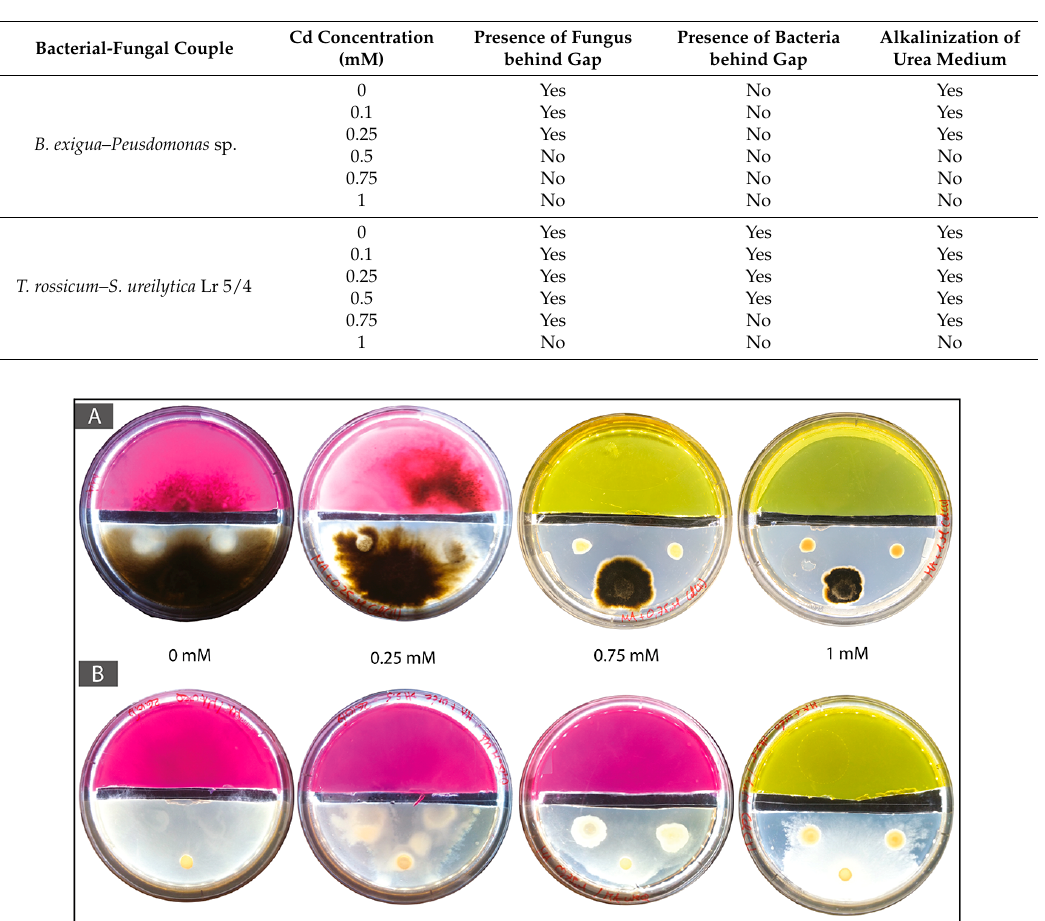
Table 3. Results of the Cd mobilization and immobilization experiment in two-compartments systems with the two synergistic couples ( B. exigua + Pseudomonas sp. and T. rossicum and S. ureilytica Lr 5/4) showing at each Cd concentration assessed whether (1) the fungus reached the immobilization area, (2) bacteria used fungal highways to reach the immobilization area, and (3) the pH increased in the immobilization area.